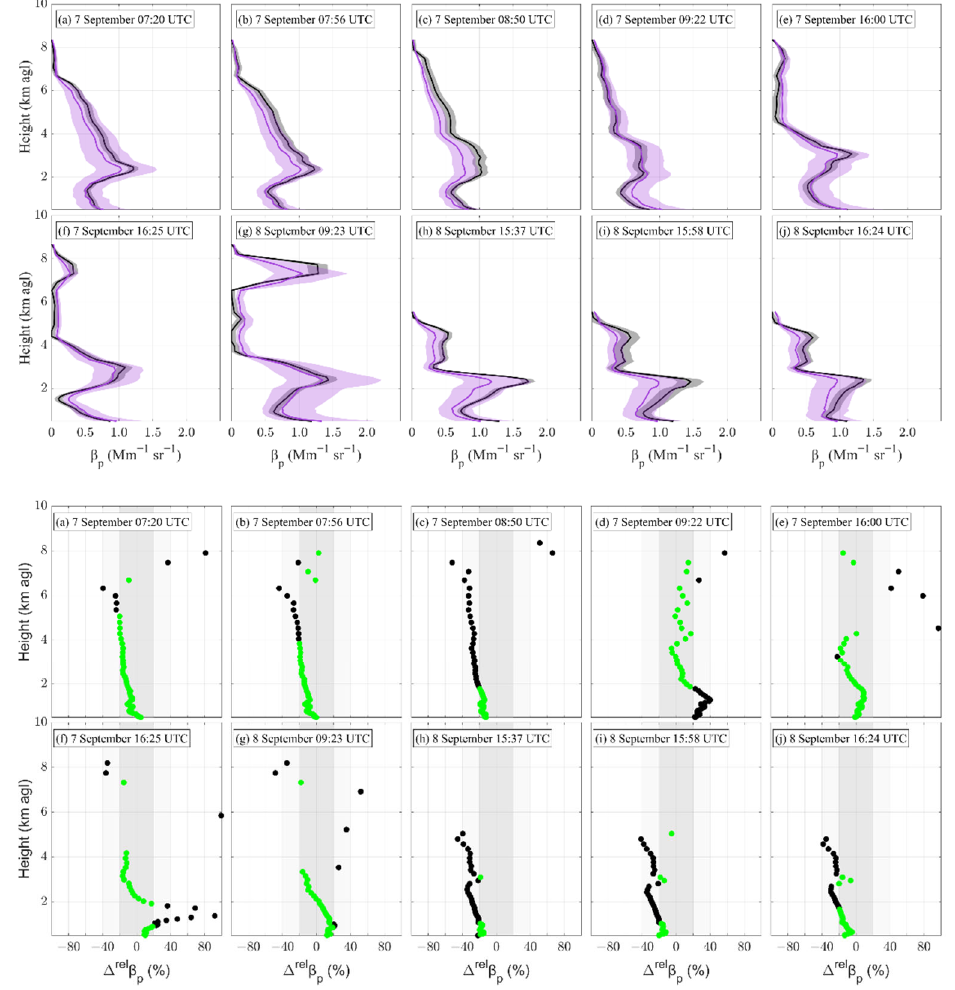
Figure 5. (Top panels) GRASP (purple) and lidar-derived (black) retrievals of the height-resolved total particle backscatter coefficient β p (Mm − 1 sr − 1 ) at 532 nm for the 10 selected biomass-burning cases (chronologically shown from ( a – j )). Errors provided by GRASP are shown by the purple shaded areas. (Bottom panels) Relative differences between GRASP and lidar-derived values, ∆ rel β p (%). Those Δ rel β p values within ±20% (marked by the shaded grey band) are indicated by green points; the rest of them are marked in black. The ±40% for the confidence interval is indicated by a shaded light-grey band. The profiles are averaged at the time interval of ± 15 min around the sun photometer measurements.